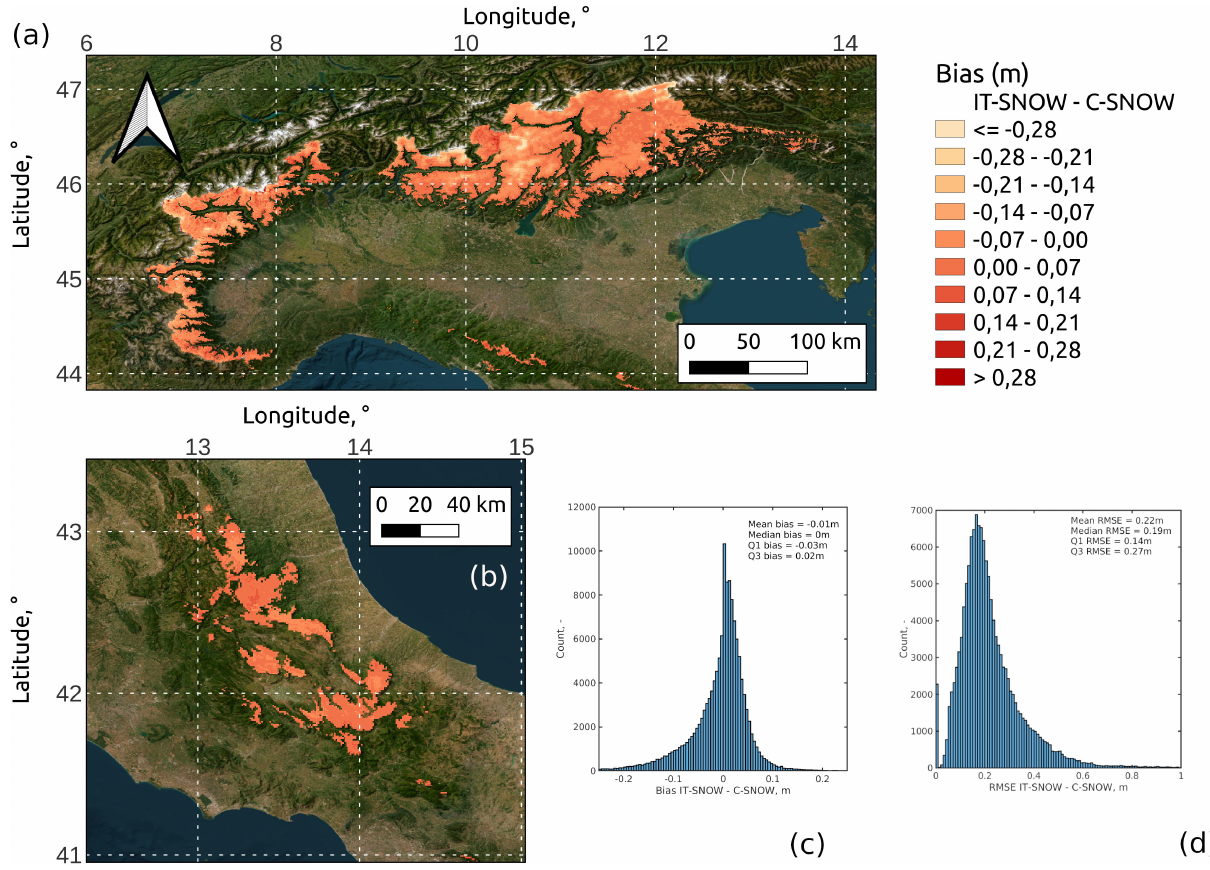
Figure 5. Evaluation of IT-SNOW using the Sentinel-1 snow depth product C-SNOW for the period September 2016 through April 2020. Pixel-wise bias for the Italian Alps (a) and the central Apennines (b) , frequency distributions of pixel-wise bias (c) and root mean square error (d) are shown. The background map is from the Esri satellite theme. Panels (a) and (b) refer to the two areas of Italy with seasonally deep snow